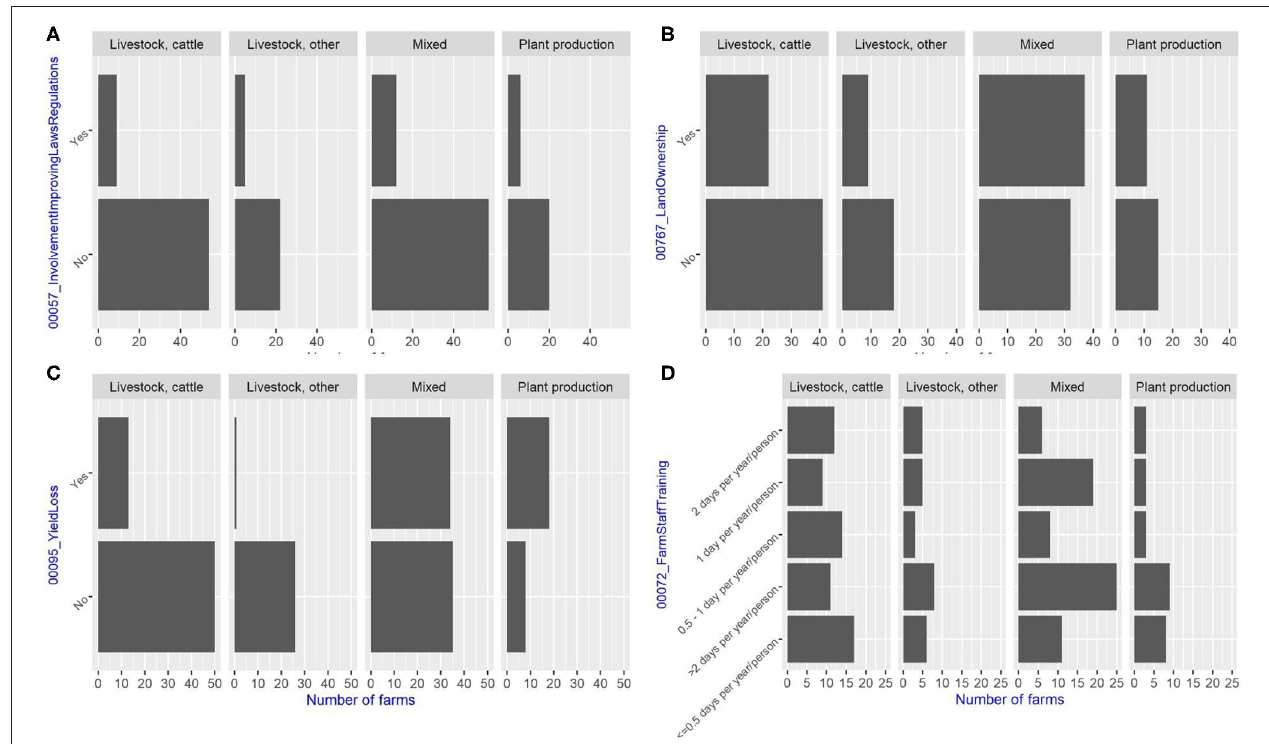
FIGURE 5 | Unrated raw responses for four prominent categorical indicators from the final set (A–D) , plotted by farm type and agricultural zone. Indicators are 00057: Involvement in Improving Laws and Regulations (A) , 00767: Land Ownership Status (B) , 00095: Incidences of Major Yield Loss (C) and 00072: Farm Staff Training Level (D)